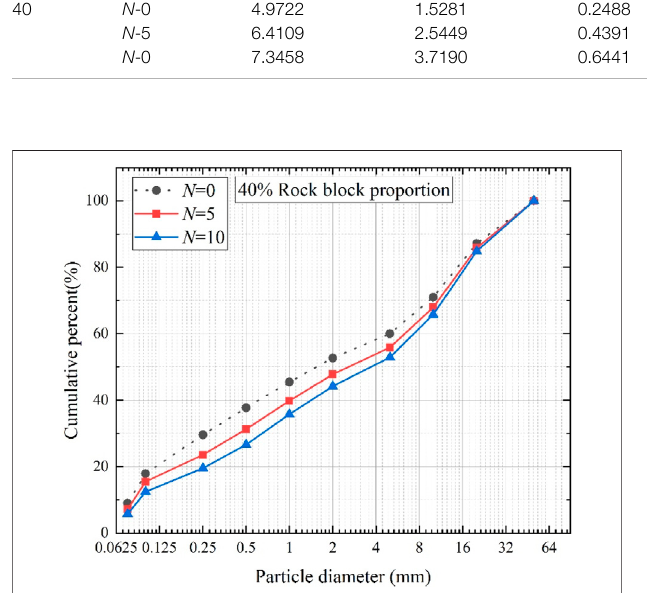
FIGURE 9 | Impact of I-AD circulations on grains composition.